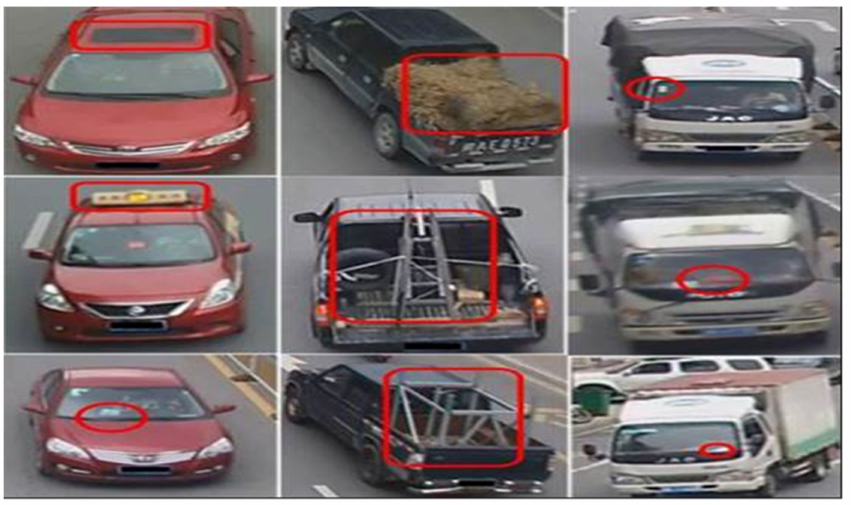
Figure 11. Shows vehicles that are same in global appearance but differentiated by local regions that are marked in red